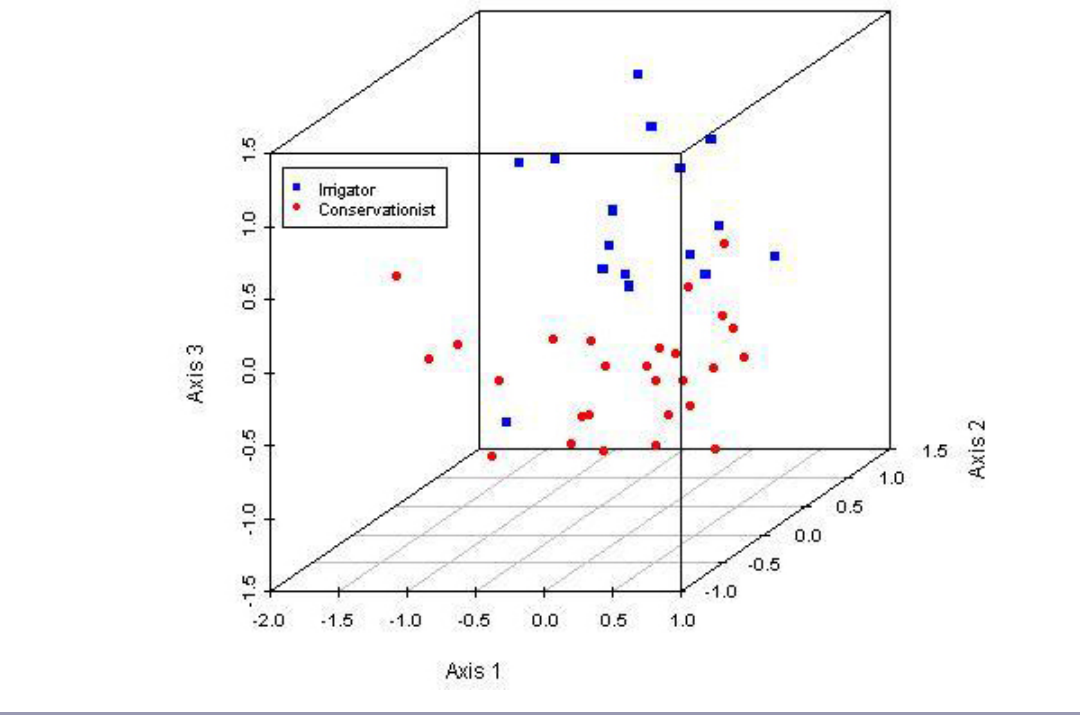
Fig. 5 . A three-dimensional MDS map of the similarities among respondents, with respect to their identification of the causes of problems with current flows in the Crocodile River (stress =